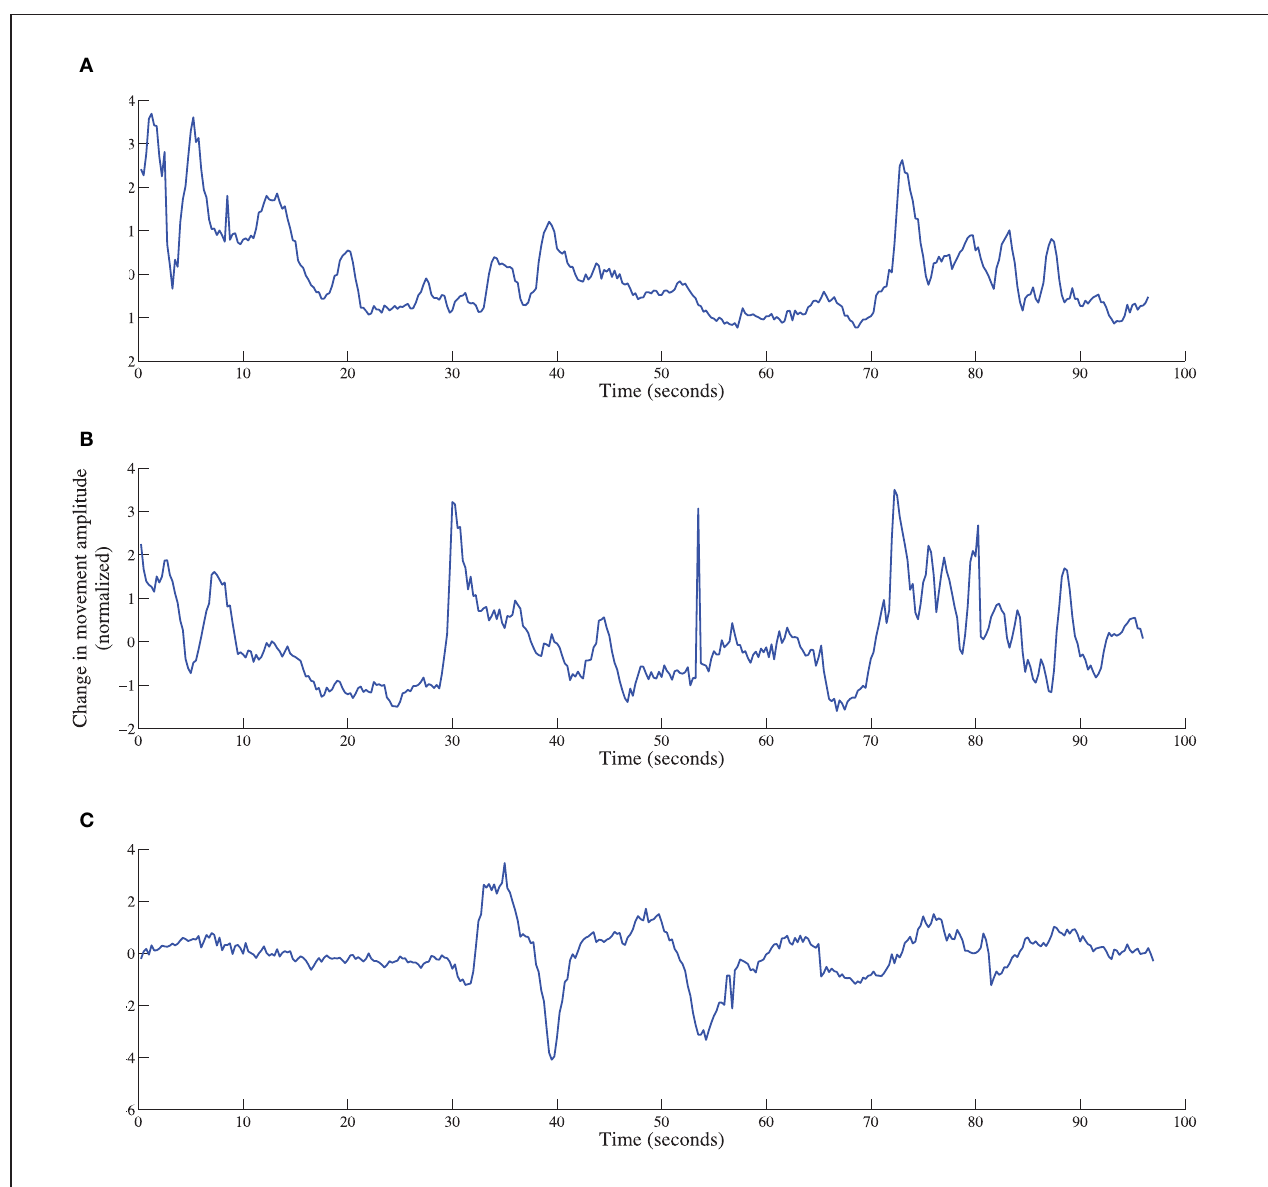
FIGURE 5 | Time series of movement displacement (based on Euclidean distance) for arms (A), head (B), and upper face (C) for a deceptive responder in the math-test condition.